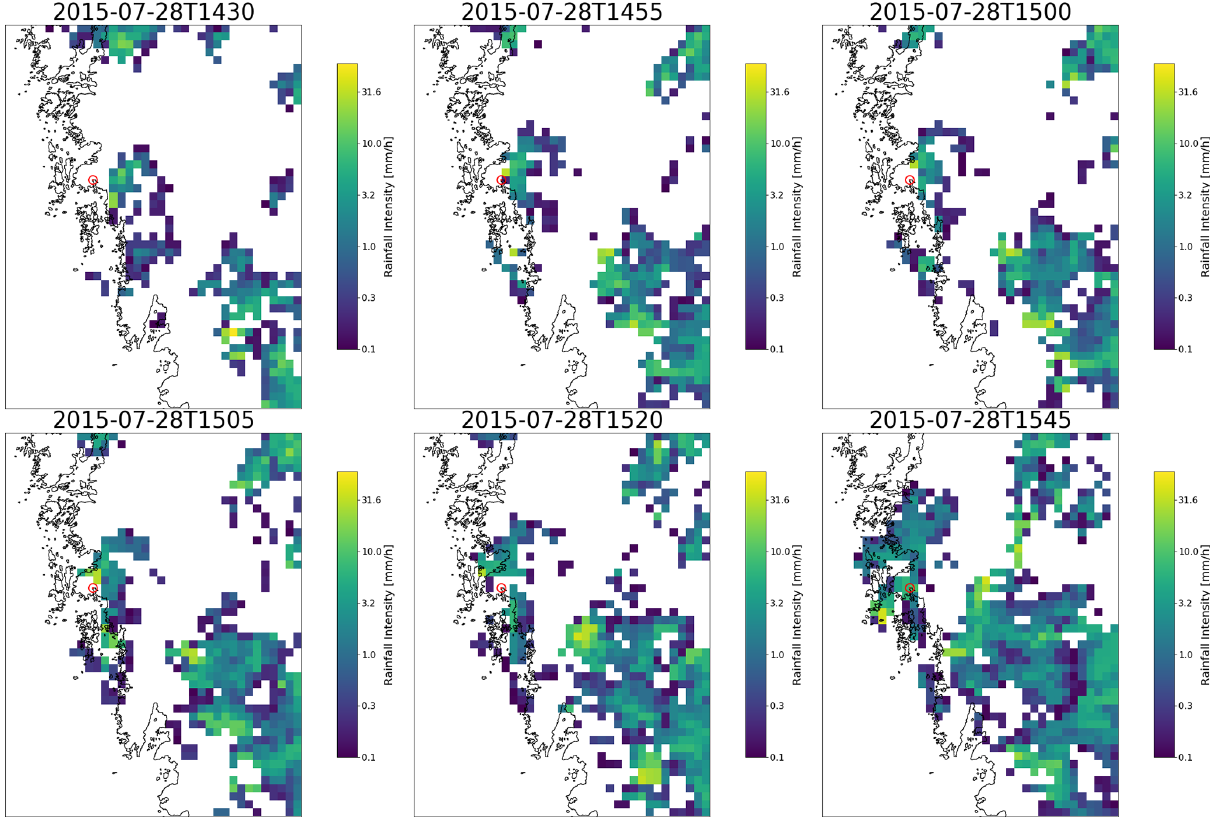
Figure 13. Estimated rainfall intensity based on the radar data at key time steps during 28 July 2015. The red circle indicates the location of the Torslanda